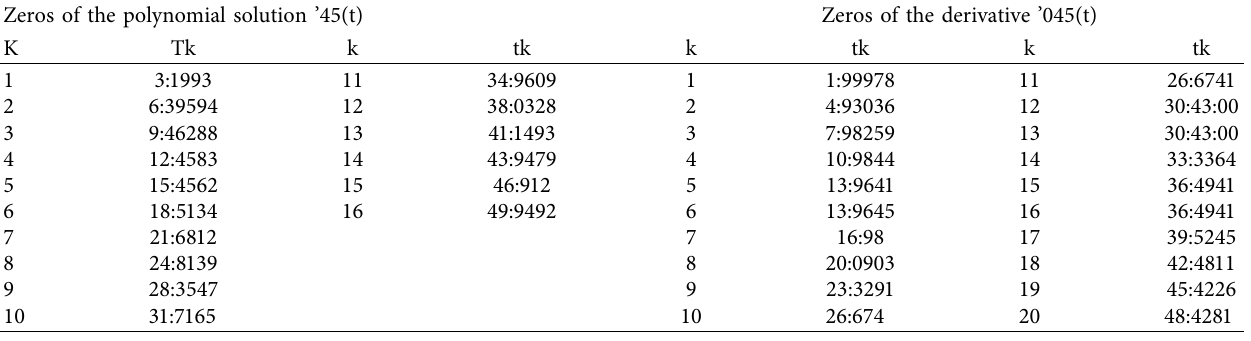
, φ , _ φ β , c , ω 0 , ω 2 , ε , 0 0 ) (cid:28) ( Ω